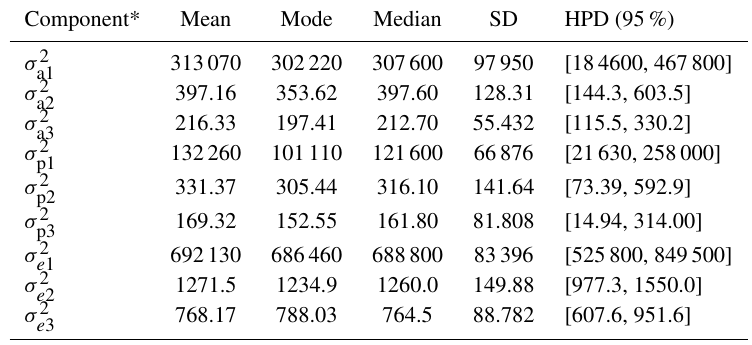
Table 3. Summary of marginal distributions of the variance components for 305 days of milk, fat, and protein yields. HPD indicates high posterior density region.